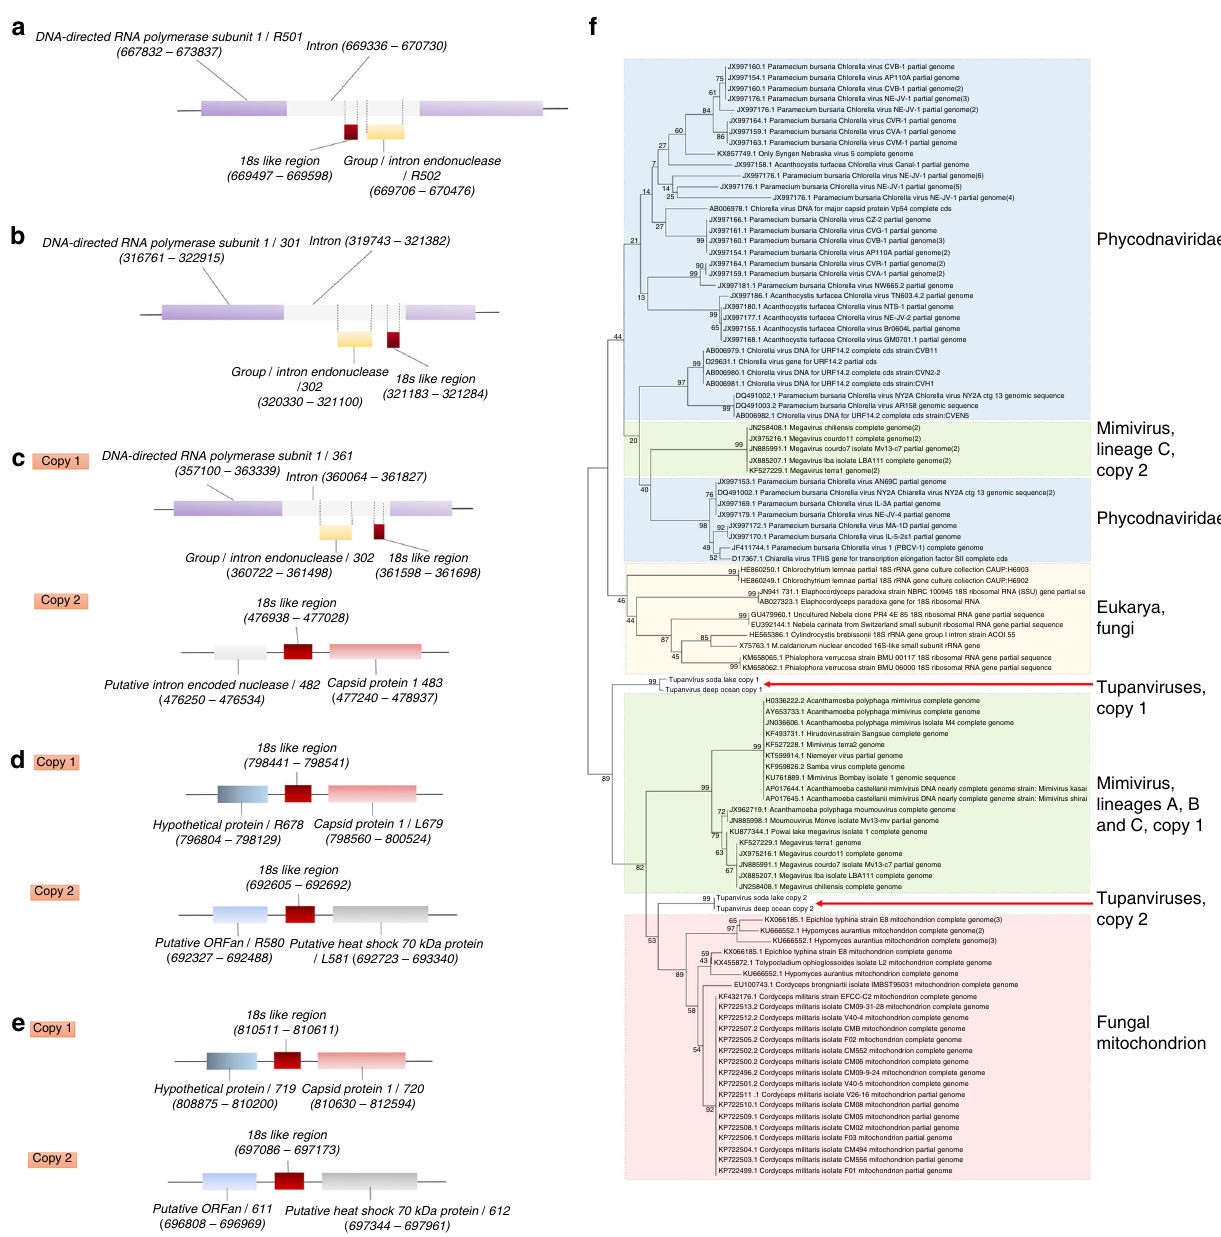
Fig. 6 Adjacent regions of 18S rRNA intronic sequences in the genus Mimivirus and Tupanvirus and maximum likelihood phylogenetic tree of 18S rRNA intronic region. Core sequences are represented for lineages A ( a ), B ( b ), C ( c ), Tupanvirus soda lake ( d ) and Tupanvirus deep ocean ( e ). Phylogenetic tree of 18S rRNA intronic region present in mimivirus ( e ), Phycodnaviridae , eukaryotes and fungi